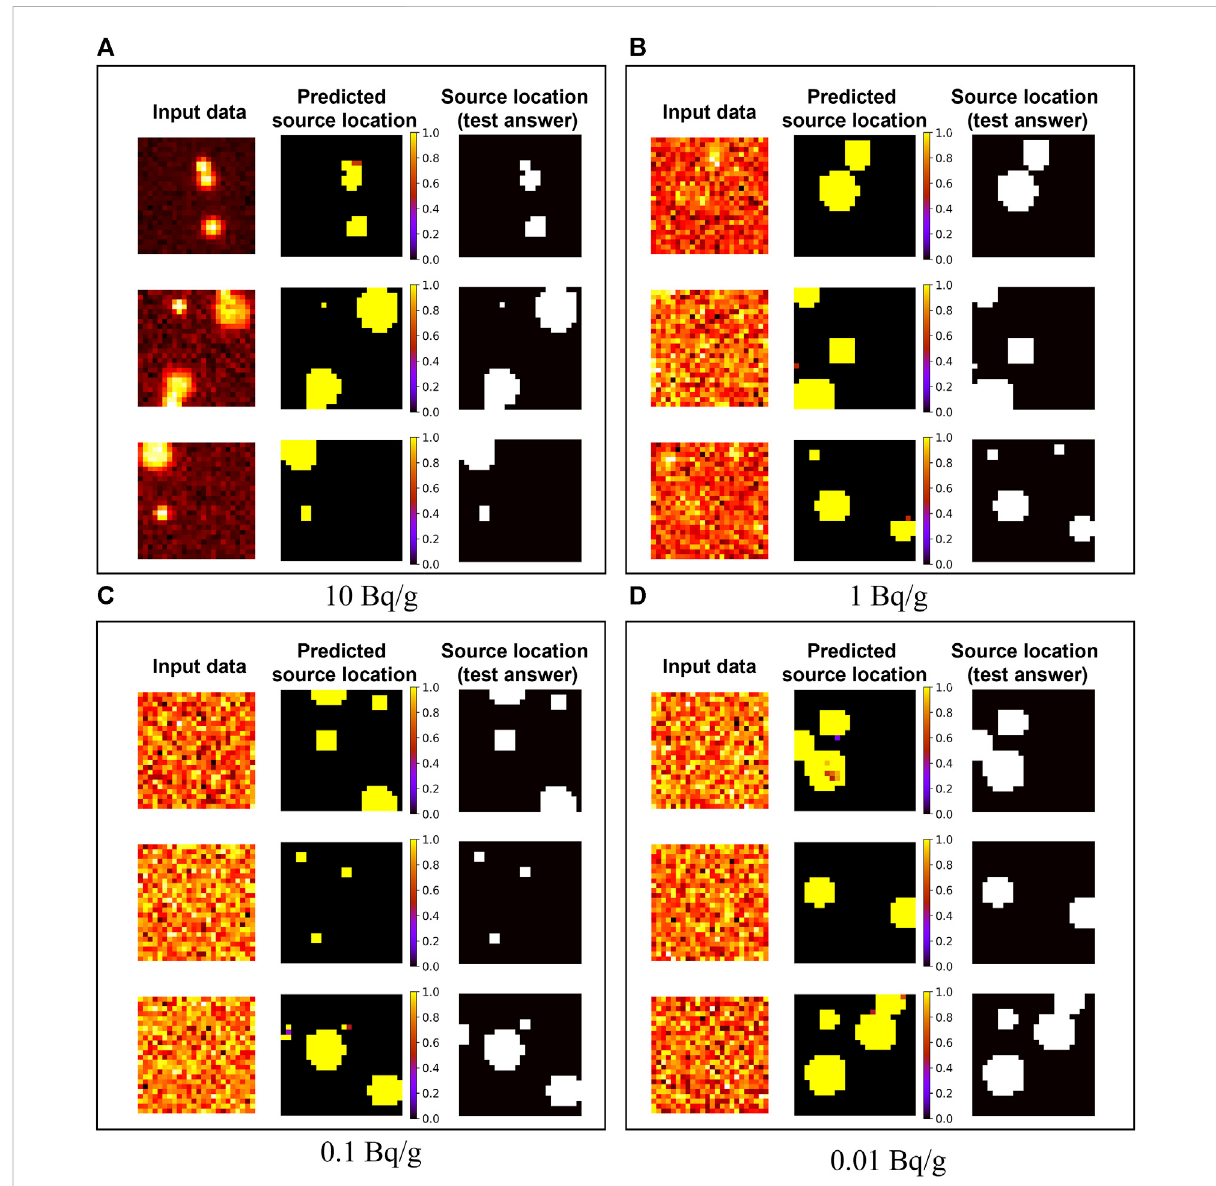
FIGURE 5 Predicted results using the ANN model trained by datasets with random background noise and equipped with a collimator. The radioactivity concentrations were as follows: (A) 10 Bq/g, (B) 1 Bq/g, (C) .1 Bq/g, and (D) .01